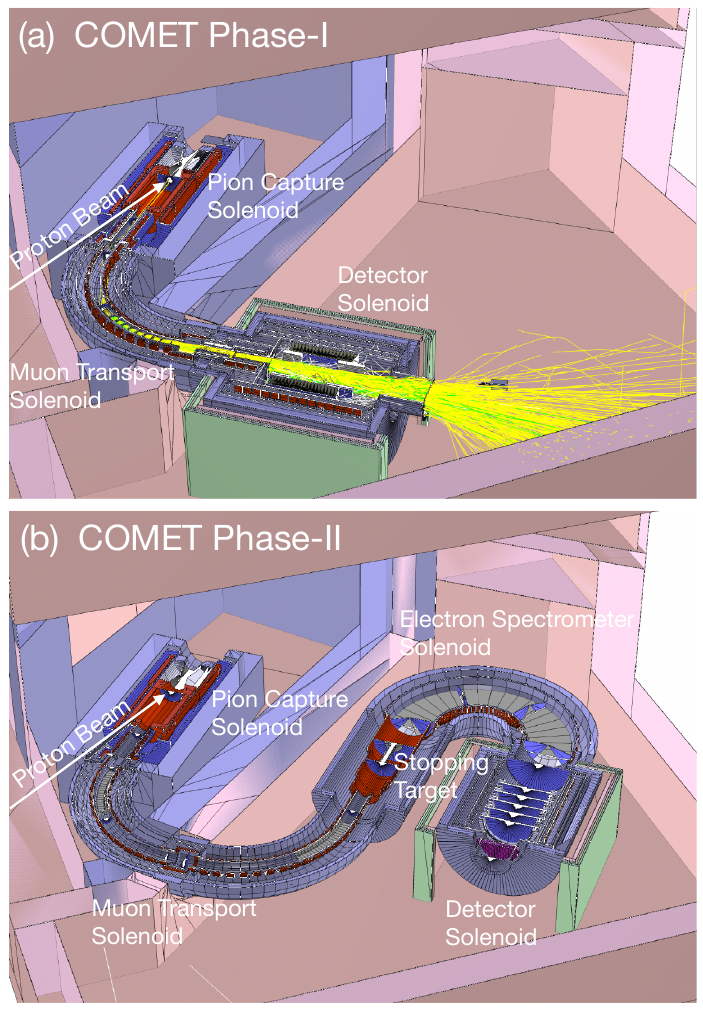
Figure 1. Schematic layouts of the COMET experiment Phase-I ( a ) and Phase-II ( b ). Simulated particles for a single beam bunch are shown for